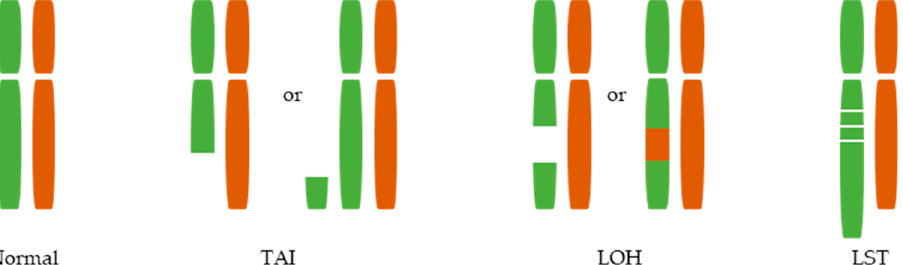
Figure 1. Large-scale genomic aberrations associated with homologous recombination deficiency. At least three large-scale genomic aberrations have been associated with HRD: telomeric allelic imbalance (TAI), defined as regions of allelic imbalance at telomeric region; loss of heterozygosity (LOH), defined as the loss of one or two alleles at a locus; and large-scale transitions (LST), defined as chromosomal breaks between regions of at least 10 Mb.